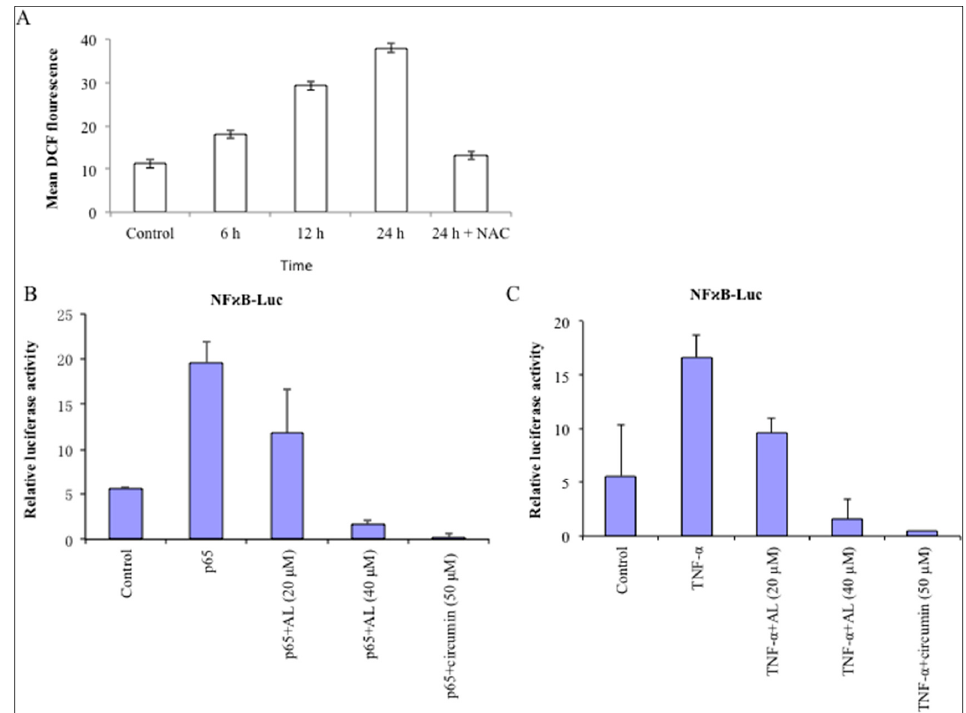
Figure 4. Altholactone promoted ROS generation and inhibited p65- and TNF- α -induced NF- κ B transcriptional activity: ( A ) DU145 cells were treated with 40 µM altholactone (AL) for 6 and 12 h or in the presence or absence of 5 mM NAC for 24 h. Data are expressed as Mean ± SD ( n = 3); ( B ) The effect of altholactone (AL) on the NF- κ B transcriptional activity. DU145 cells were transiently co-transfected with p65 expression plasmid and NF- κ B-Luciferase plasmid. At 16 h after transfection, cells were treated with the indicated concentrations of altholactone for 8 h and then harvested for luciferase and β -galactosidase assays; ( C ) the effect of altholactone on TNF- α -enhanced transcriptional activity of NF- κ B. After 16 h of transfection, cells were treated with the indicated doses of altholactone (AL) for 8 h, and then prior to harvest for luciferase and β -galactosidase assays, cells were treated with TNF- α for stimulation. Curcumin, a NF- κ B inhibitor, was used as positive control in this study. Data are expressed as mean ± SD ( n = 3).